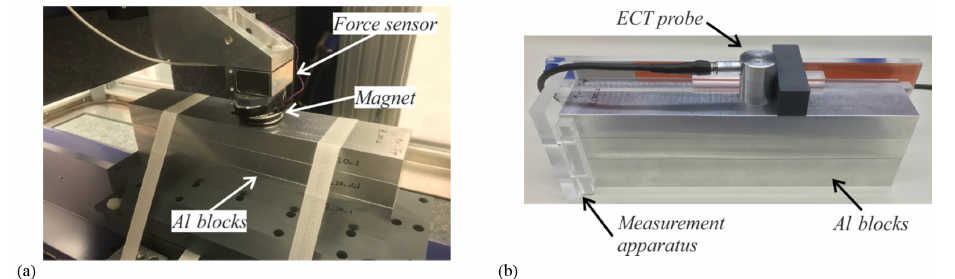
Figure 2. Measurement setups for LET (a) and ECT (b)